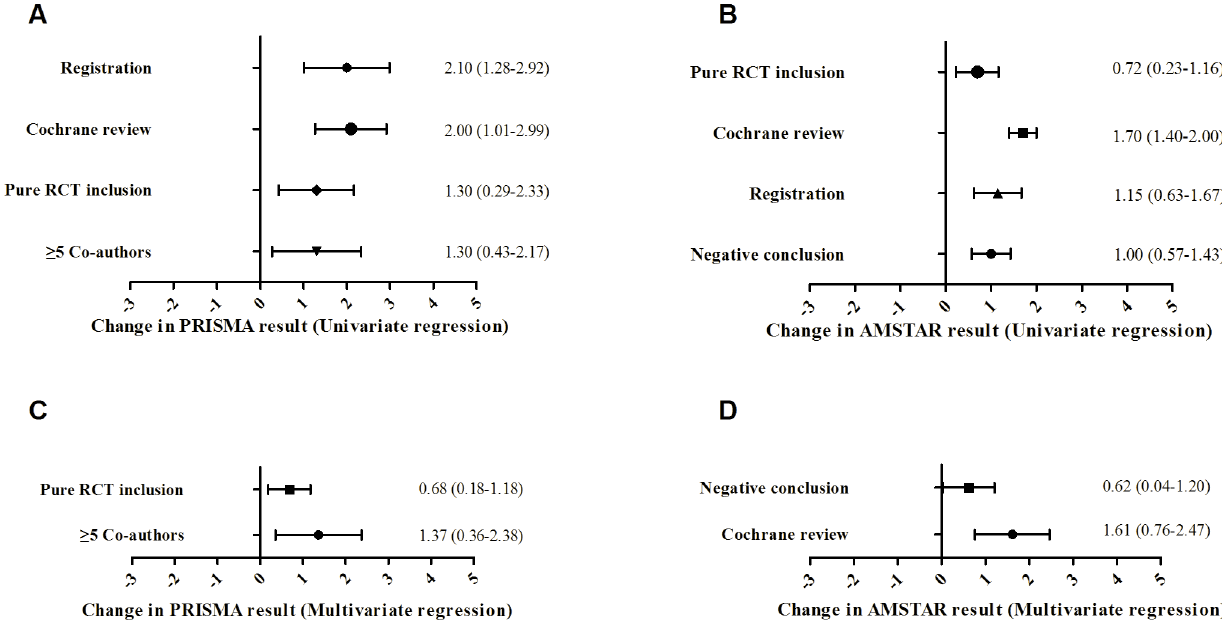
Fig 4. Scatter graph of AMSTAR and PRISMA results with a linear model. A deeper color indicates more dense points. R refers to the correlation coefficient.